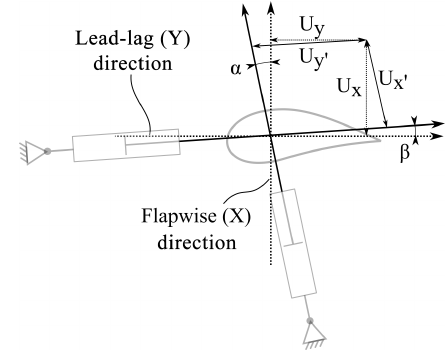
Figure 3. Blade coordinate system and skew coordinate system of